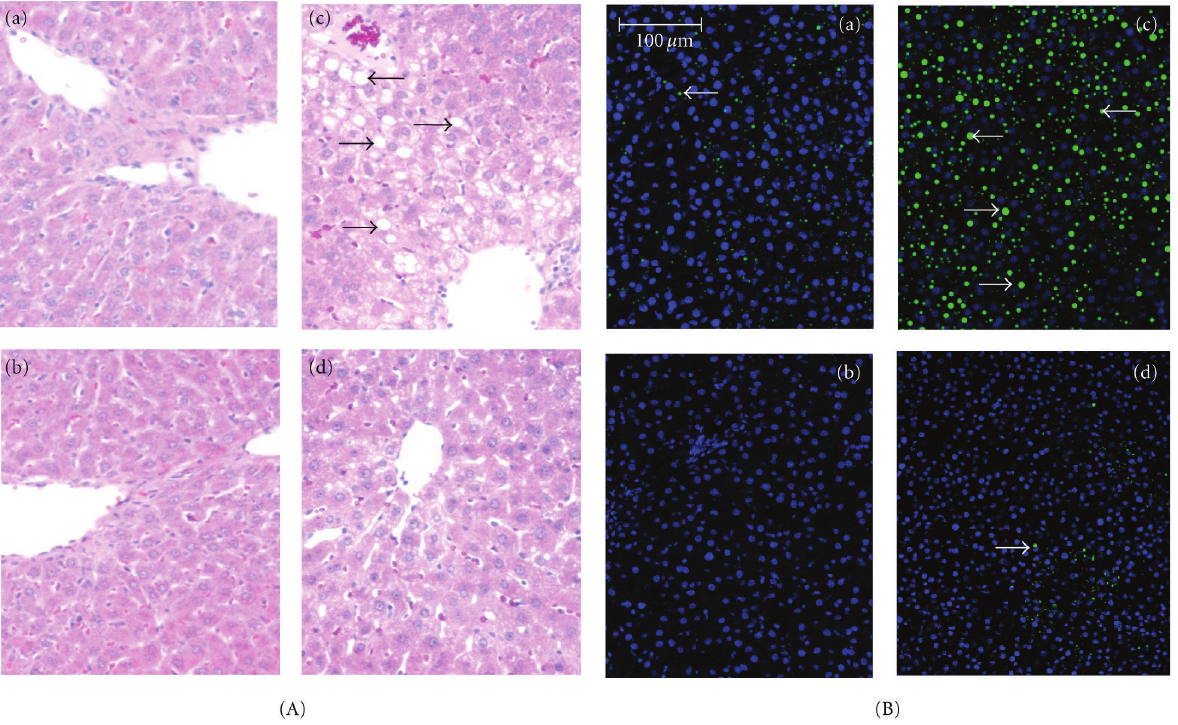
Figure 1: Betaine attenuates chronic ethanol-dependent steatosis. Hematoxylin-eosin (A) and BODIPY 493/503-DAPI (B, green BODIPY- labeled lipid droplets, nuclei blue) stained images from representative livers of (a) control; (b) control + betaine; (c) ethanol; (d) ethanol + betaine rats ( n = 8 rats’/group) fed the respective diets for 4-5 weeks. Liver sections of the representative ethanol-fed rat stained with hematoxylin-eosin or BODIPY 493/503-DAPI shows micro- and macrovesicular steatosis (arrows).